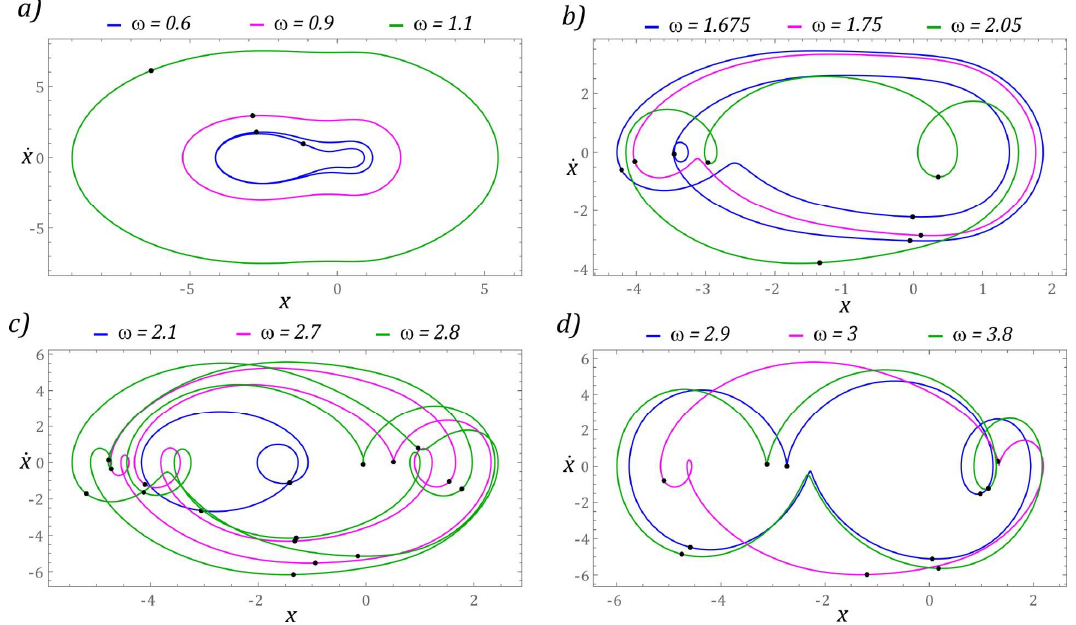
Figure 7. Sample graphic images of periodic solutions. The black points correspond to the Poincaré maps. The cases ( a – d ) show the selected solutions for increasing ω .